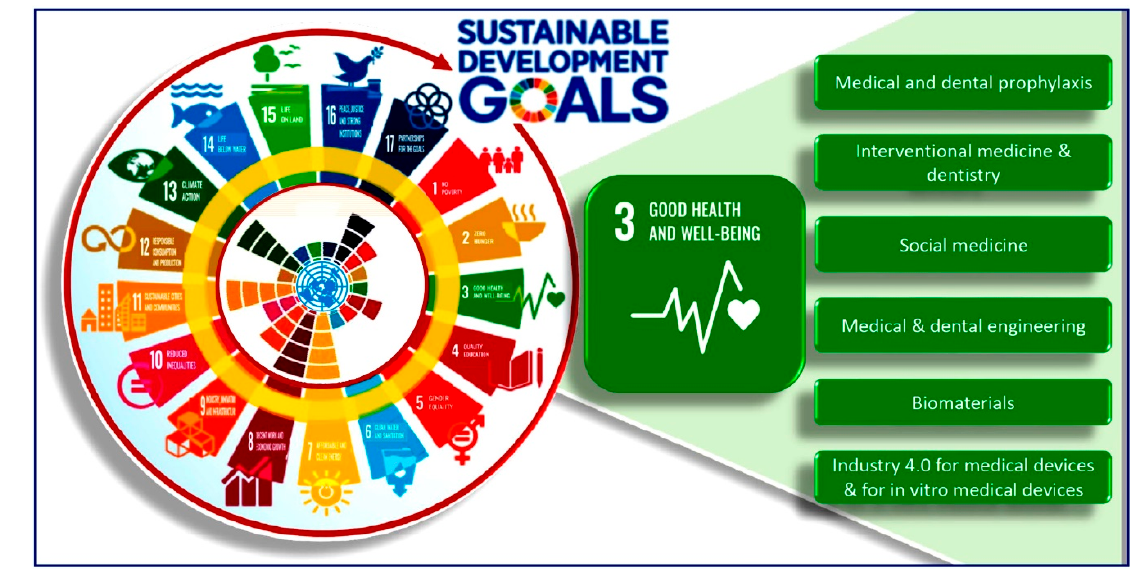
Figure 1. Diagram linking the UN Sustainable Development Goals with selected detailed aspects of good health and well-being of people, including the organization of medical care and the design and production of medical devices necessary in these activities.